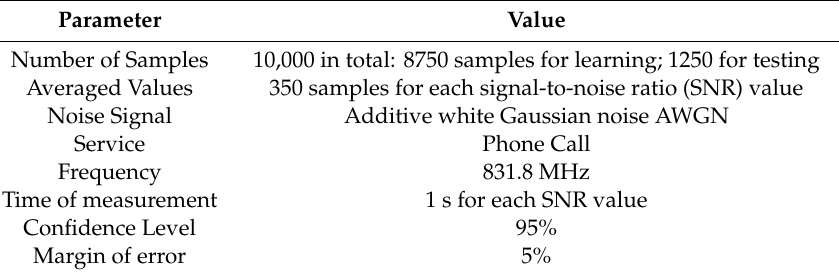
Table 2. Learning process